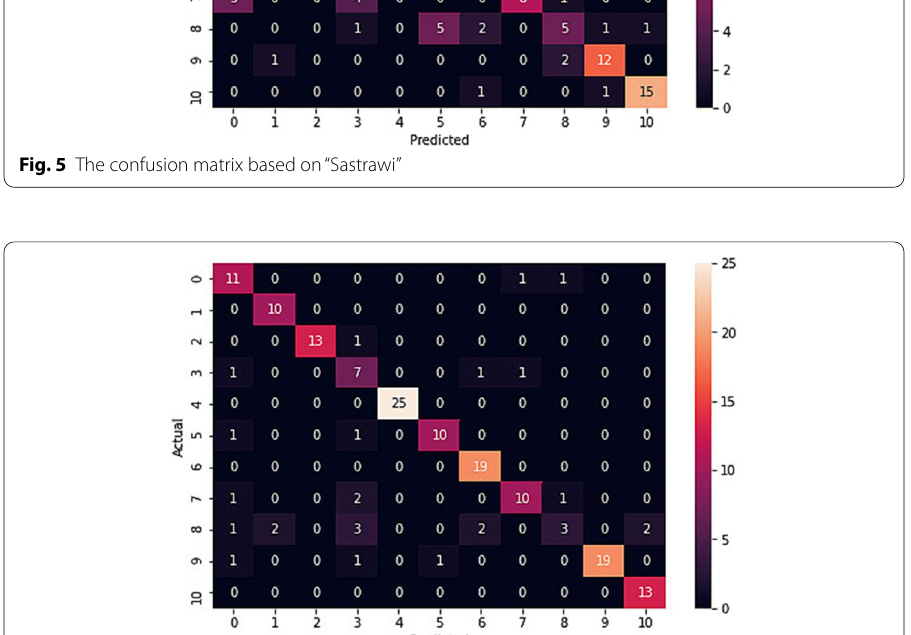
Fig. 6 The confusion matrix based on